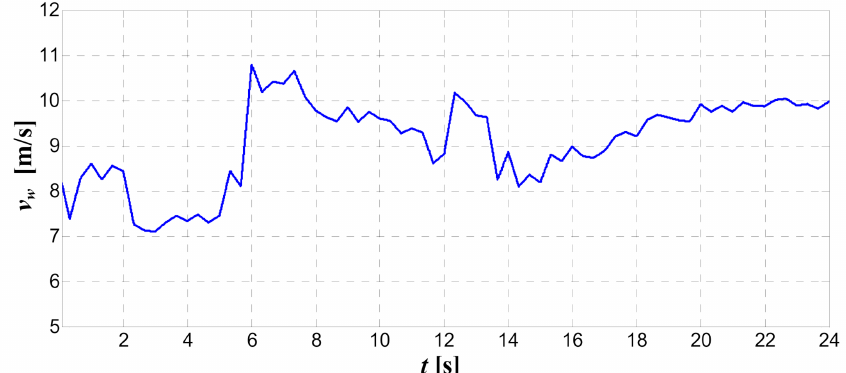
Figure 16. Assumed waveform of wind speed v w